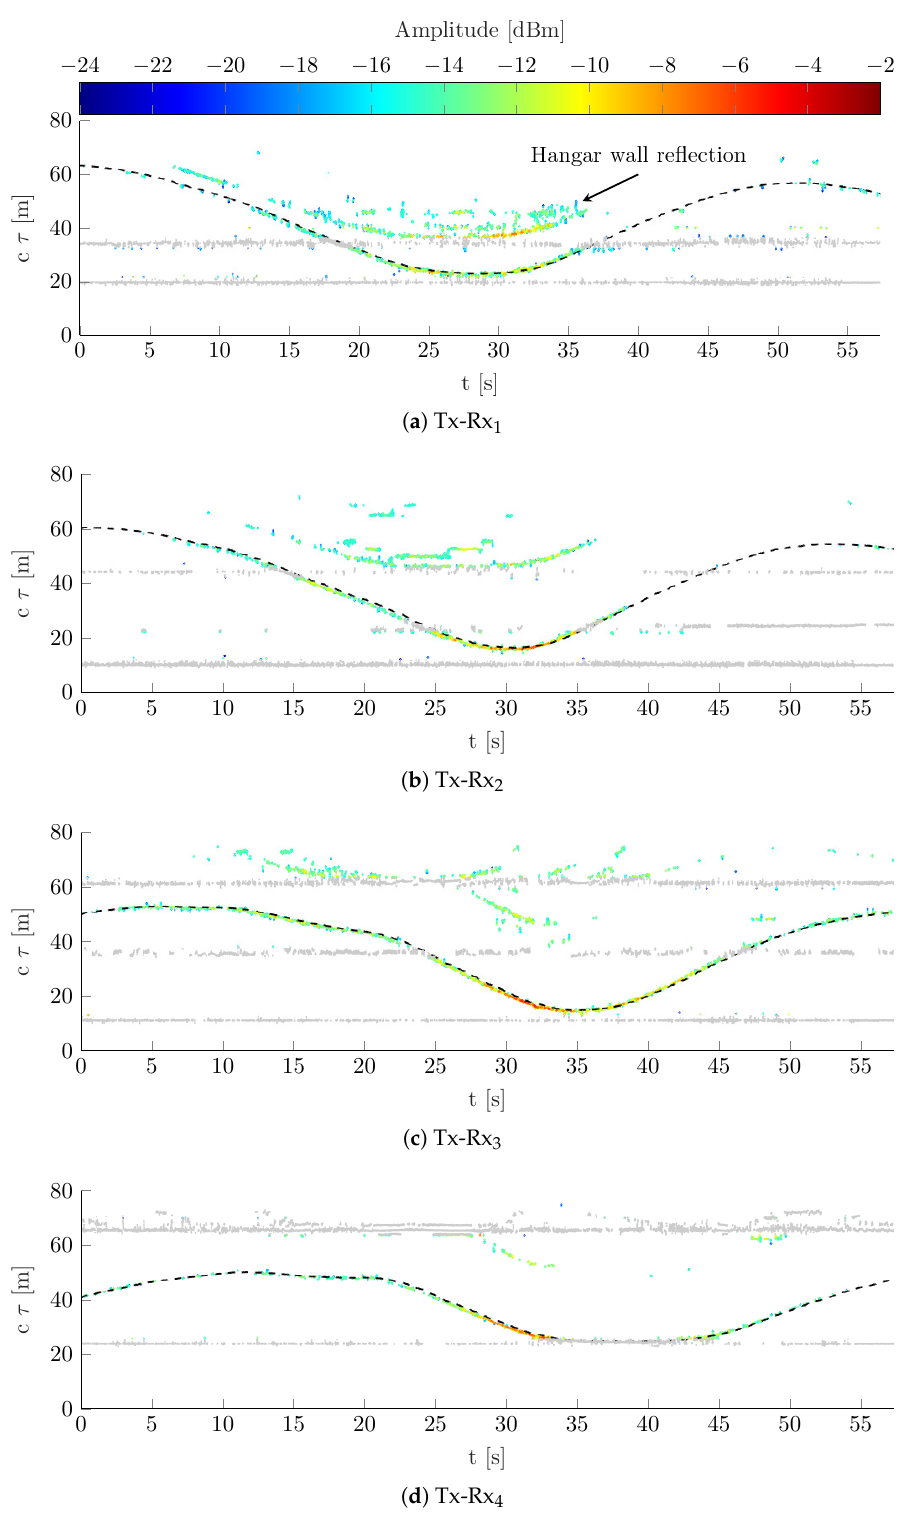
Figure 4. Estimation results of KEST for CIR over time of moving pedestrian. Extracted mobile MPC is colored according to the estimated amplitude level. LoS and static MPCs are shown in gray. Dashed black lines indicate delays from ground truth data. Other mobile MPCs deviating from ground truth can be referred to double reflections of moving pedestrian and hangar